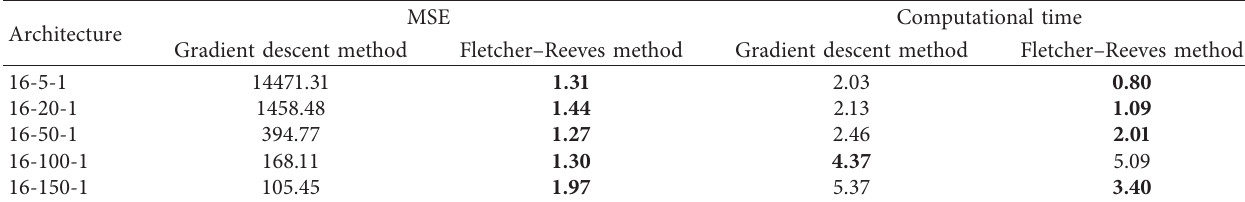
Table 4: Evaluation results using training data for several architectures with a learning rate of 0.005. MSE Architecture